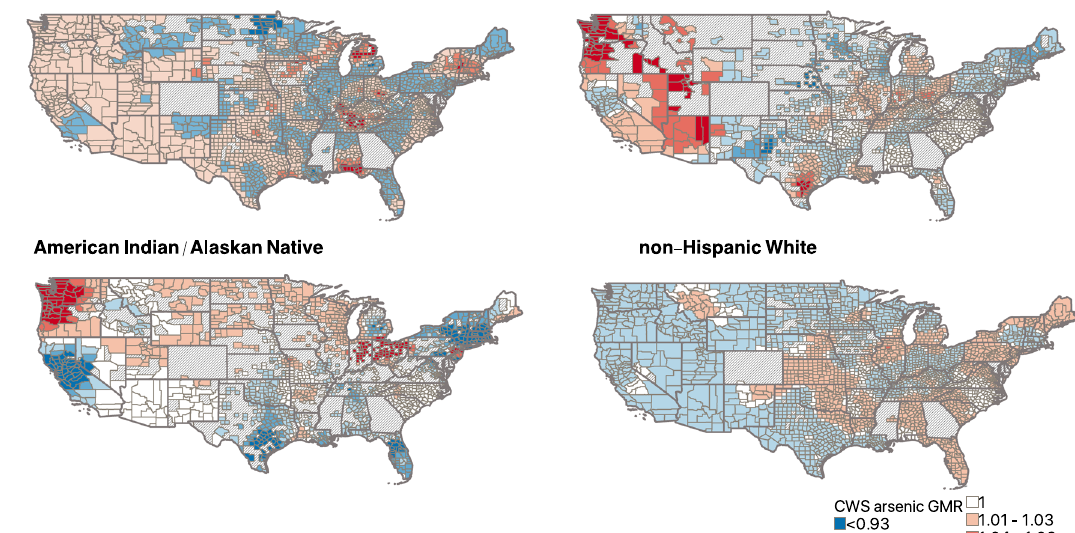
colors, counties with a negative effect estimate (GMR<1) are shown in blue scale colors, and counties where a nulleffectestimate was observed are shown inwhite. Counties with missing data are shown with light gray hatch marks. The number of counties included in the geographically weighted regression analysis for each racial/ethnic group were: non-Hispanic Black ( n =1848), American Indian/Alaskan Native ( n =1522), Hispanic/Latino ( n =2341), and non-Hispanic White ( n =2585).